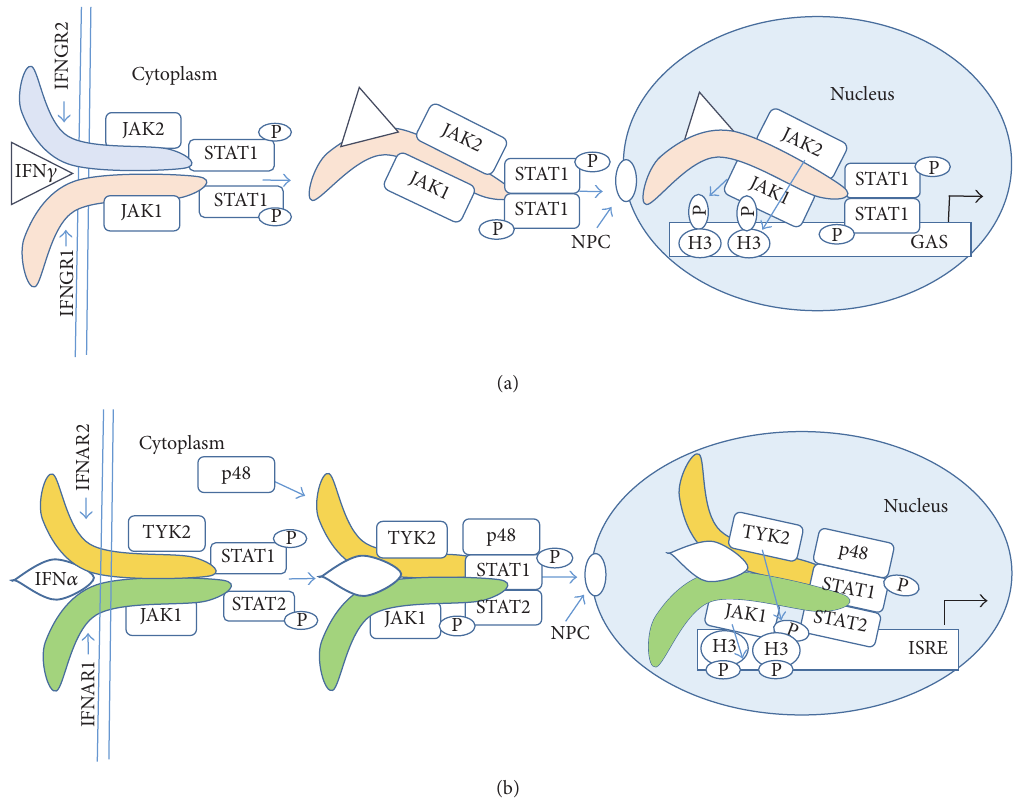
Figure 3: The noncanonical model of IFN 𝛾 (a) and IFN 𝛼 (b) signaling. (a) Binding of IFN 𝛾 to its receptor extracellular domain is followed by movement to IFNGR1 cytoplasmic domain in conjunction with endocytosis. The cytoplasmic binding increases the affinity of JAK2 for IFNGR1, which is the basis for its movement from IFNGR2 to IFNGR1. This results in autoactivation of the JAKs, phosphorylation of IFNGR1cytoplasmicdomain,andthebindingandphosphorylationofSTAT1 𝛼 atIFNGR1.ThecomplexofIFN 𝛾 /IFNGR1/STAT1 𝛼 /JAK1/JAK2 undergoes active nuclear transport where the classic polycationic NLS of IFN 𝛾 plays a key role for this transport to genes in the nuclei that are specifically activated by IFN 𝛾 . JAKs are involved in epigenetic events that cause heterochromatin destabilization and promoter activation. Histone H3 phosphorylation at Tyr 41 by JAK1 and JAK2, indicated by arrows, is a key epigenetic event in IFN 𝛾 gene activation. (b) IFN 𝛼 signaling involves the endocytosis of IFN 𝛼 and both of its receptor subunits. This complex binds to p48 to generate interferon stimulated gene factor 3 (ISGF3). IFN 𝛼 /IFNAR1/IFNAR2/JAK1/TYK2/p48 are then translocated to the promoter ISRE, where JAK1 and TYK2 are involved in phosphorylation of histone H3. GAS, IFN gamma activated sequence; H3, histone H3; ISRE, IFN sensitive response element; NPC, nuclear pore